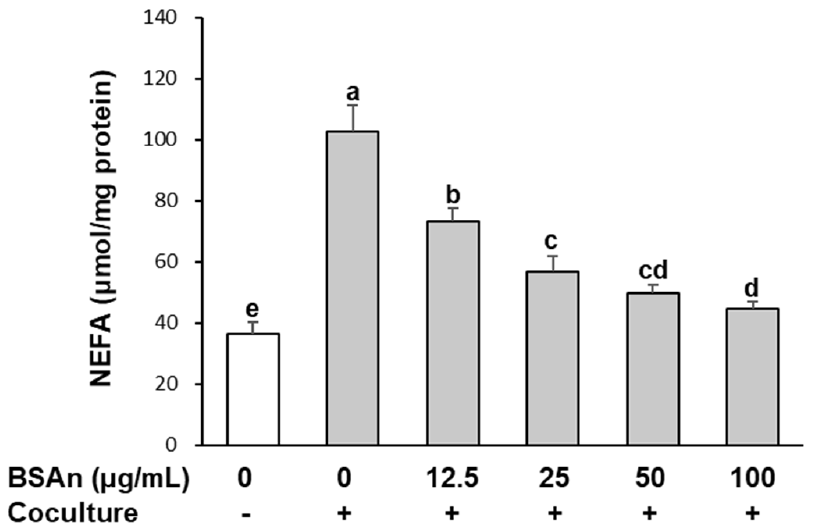
Figure 5. Effect of black soybean anthocyanin extract (BSAn) on the release of free fatty acids in the coculture of adipocytes and macrophages. Hypertrophied 3T3-L1 adipocytes were cocultured with RAW264.7 macrophages for 24 h and then treated with BSAn for 24 h in the contact system. Concentration of non-esterified fatty acid (NEFA) in the coculture medium was measured by NEFA kits. Data are presented as mean ± SD of three independent experiments. a,b,c,d,e Means without the same letter are significantly different by ANOVA, followed by Duncan’s test ( p < 0.001). +: adipocytes were cocultured with macrophages, -: adipocytes and macrophages were separately cultured and mixed